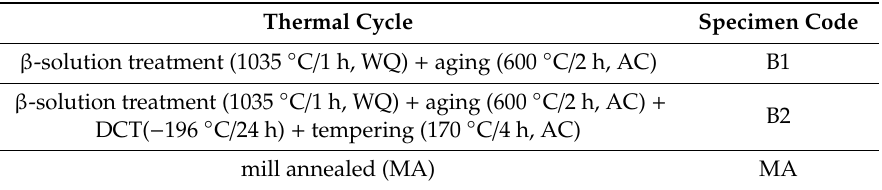
Table 3. Details of thermal